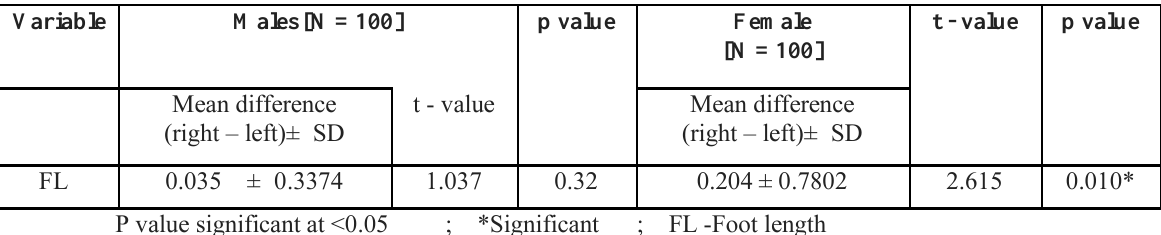
Table 2. Bilateral differences in measurement (in cm) of feet in males & females.